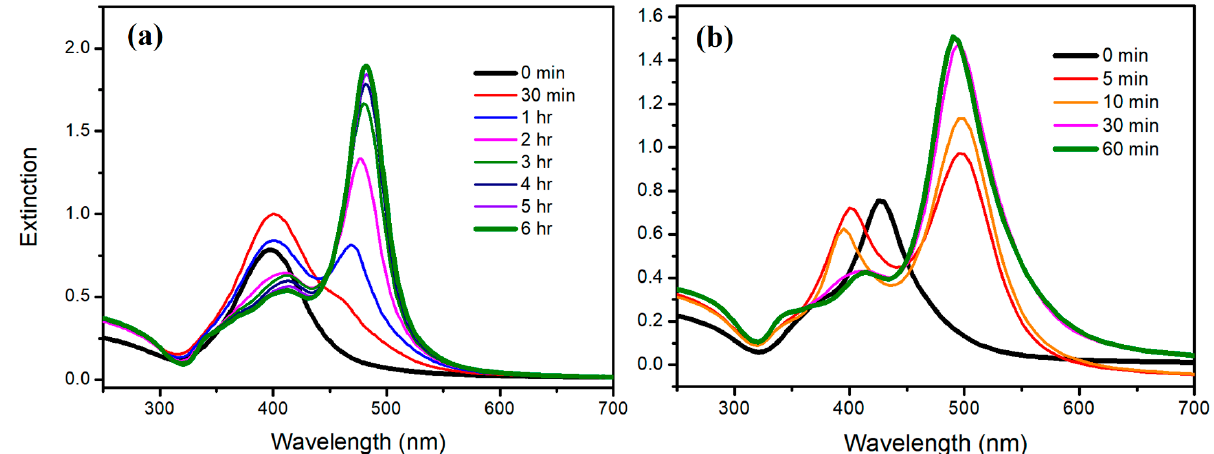
Figure 7. Time-dependent extinction spectra of silver colloids under the irradiation of blue LED for the reconstruction process, using the blunt D-AgNPs as the seeds (as shown in Figure 6) at ( a ) 10 °C and ( b ) 60 °C .